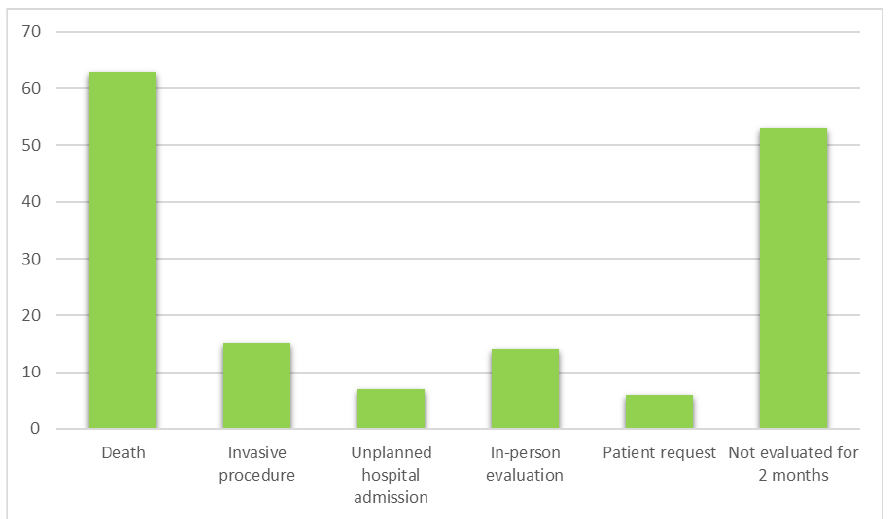
Figure 2. Reasons for interruption of the telemedicine pathway ( n = 158).